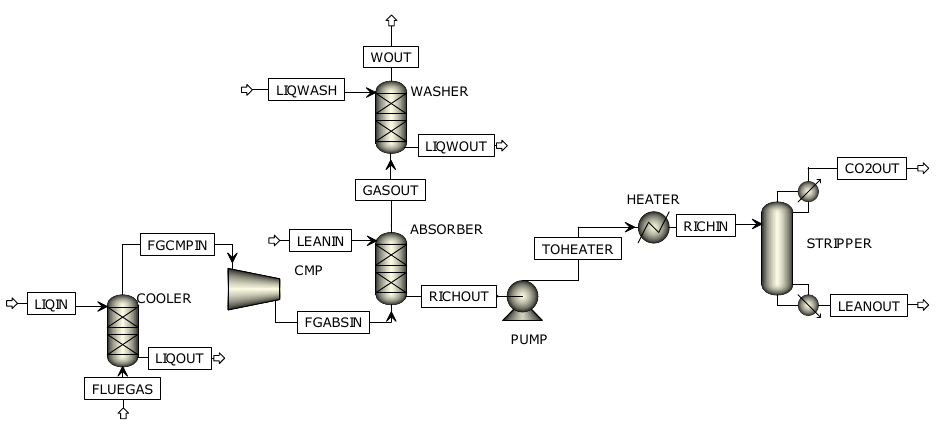
Figure 4. Main flow sheet overview of Aspen Plus Model used for the simulation.